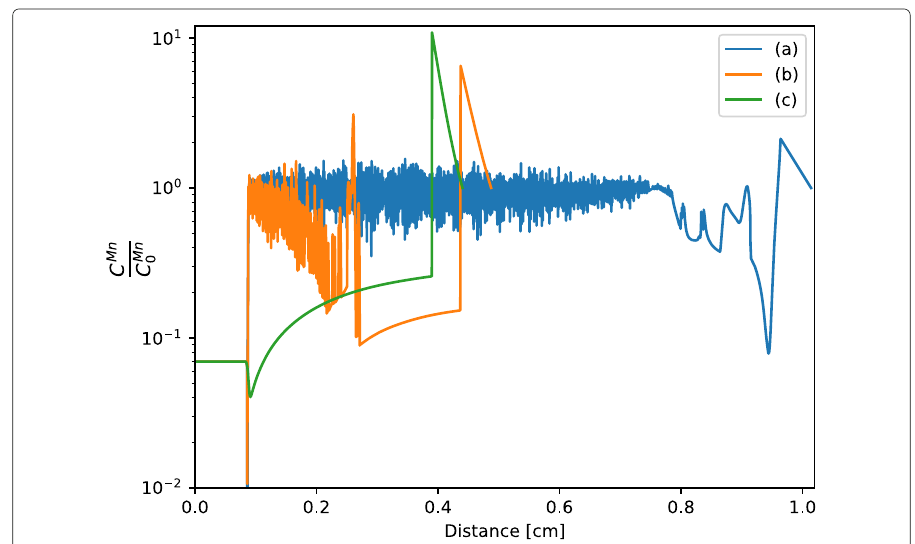
Fig. 6 Normalized Mn-concentration as a function of z for case (a), (b) and (c) at t = 400 s from Fig. 4, z=0 corresponds to the bottom of the simulation domain